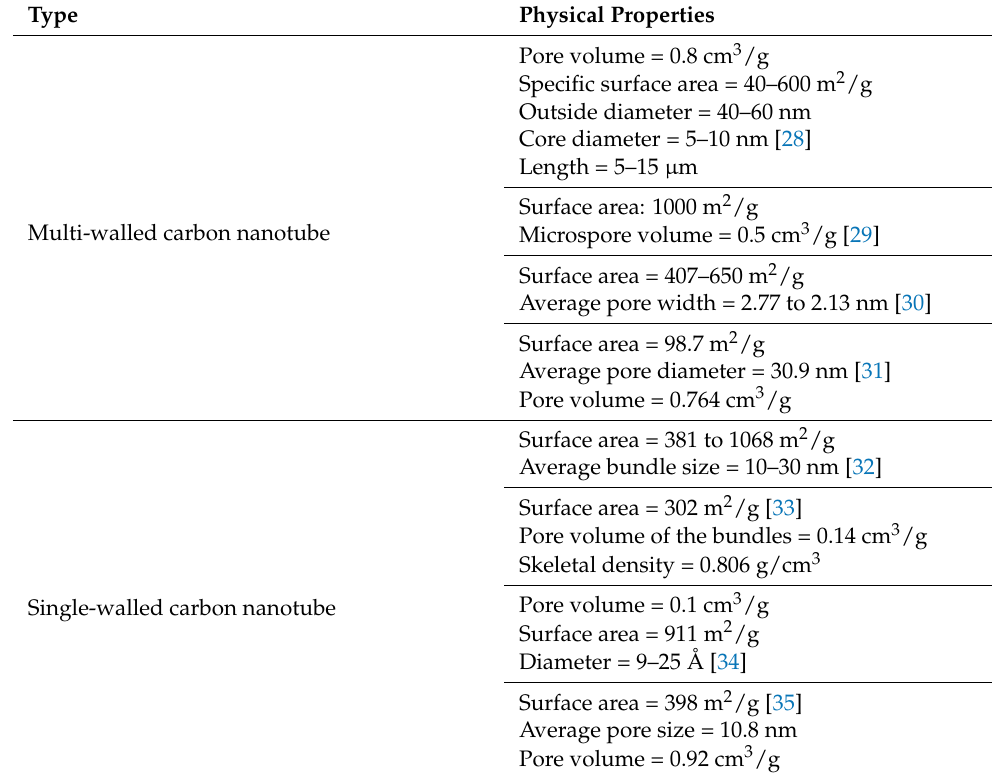
Figure 7. Internal view of single-walled carbon nanotube (SWCNT) and multi-walled nanotube (MWCNT) [24]. Table 2. Physical properties of prepared carbon nanotube.